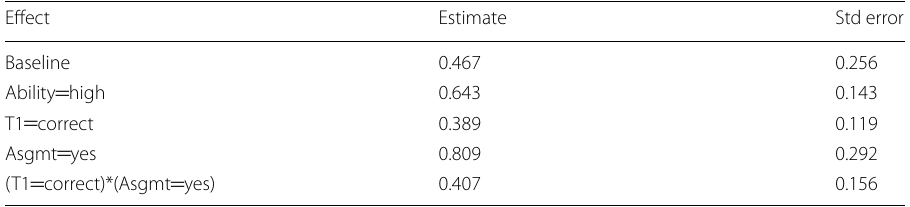
Table 4 Effect of Ability, Asgmt and T1 on the log-odds of correctly answering an isomorphic Test 2 question. The baseline is for a low-ability student who incorrectly answered the question in Test 1, for a question not previously seen in an assignment Effect Estimate Std error Baseline 0.467 Ability =